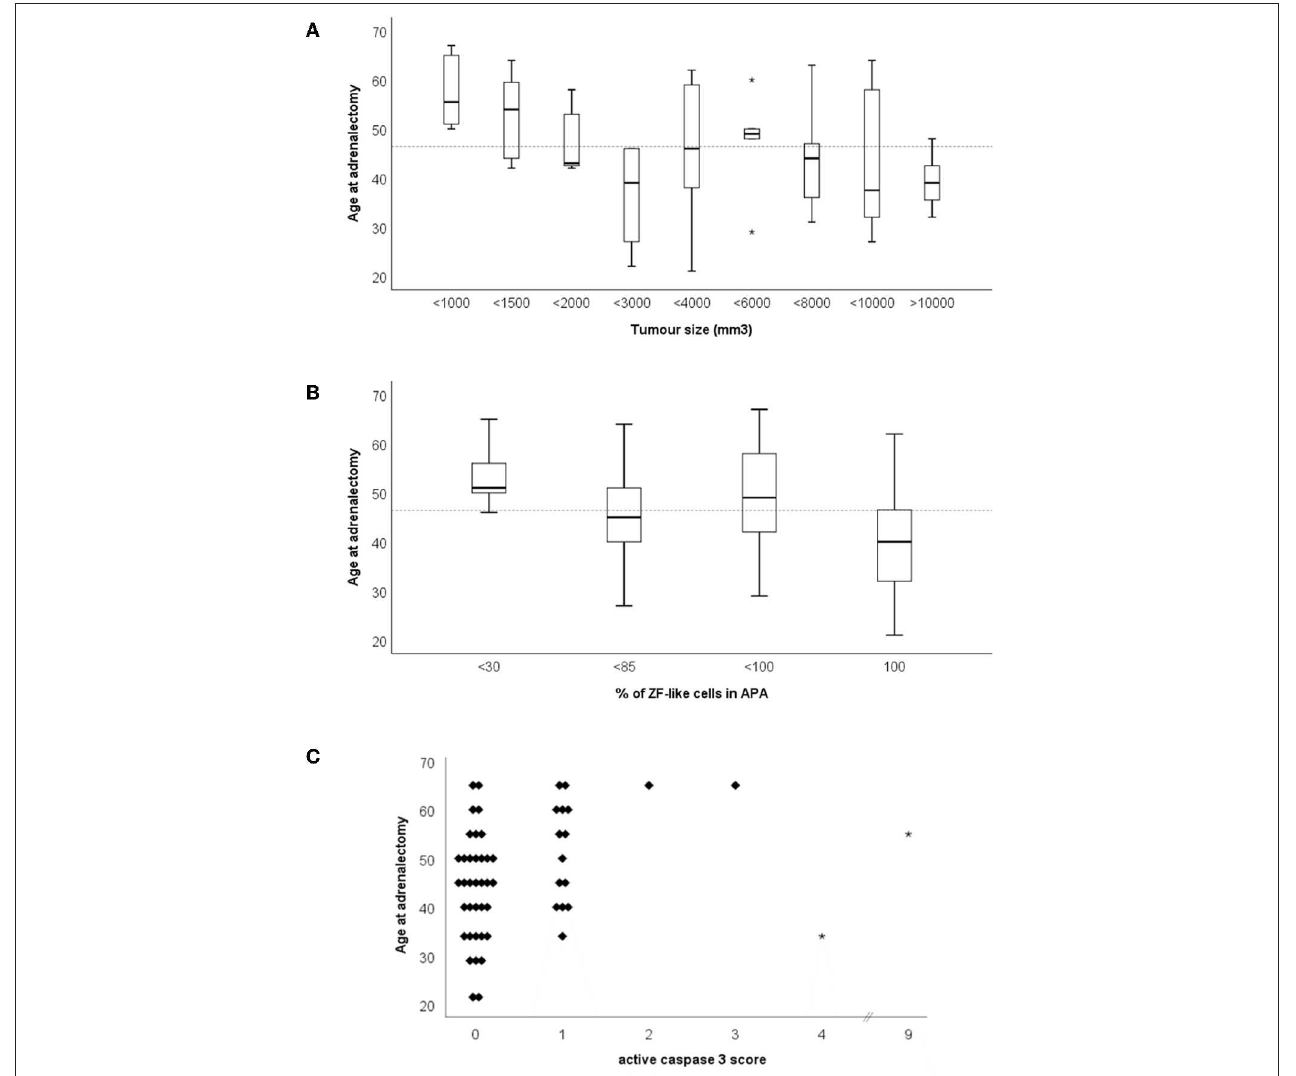
FIGURE 4 | Age of adrenalectomy correlations with (A) tumor size, (B) percentage of ZF-like cells in APA (i.e., cells with high cytoplasm: nucleus ratio), and (C) active caspase three score. *Dotted line represents the mean age of adrenalectomy (46.4 years old).